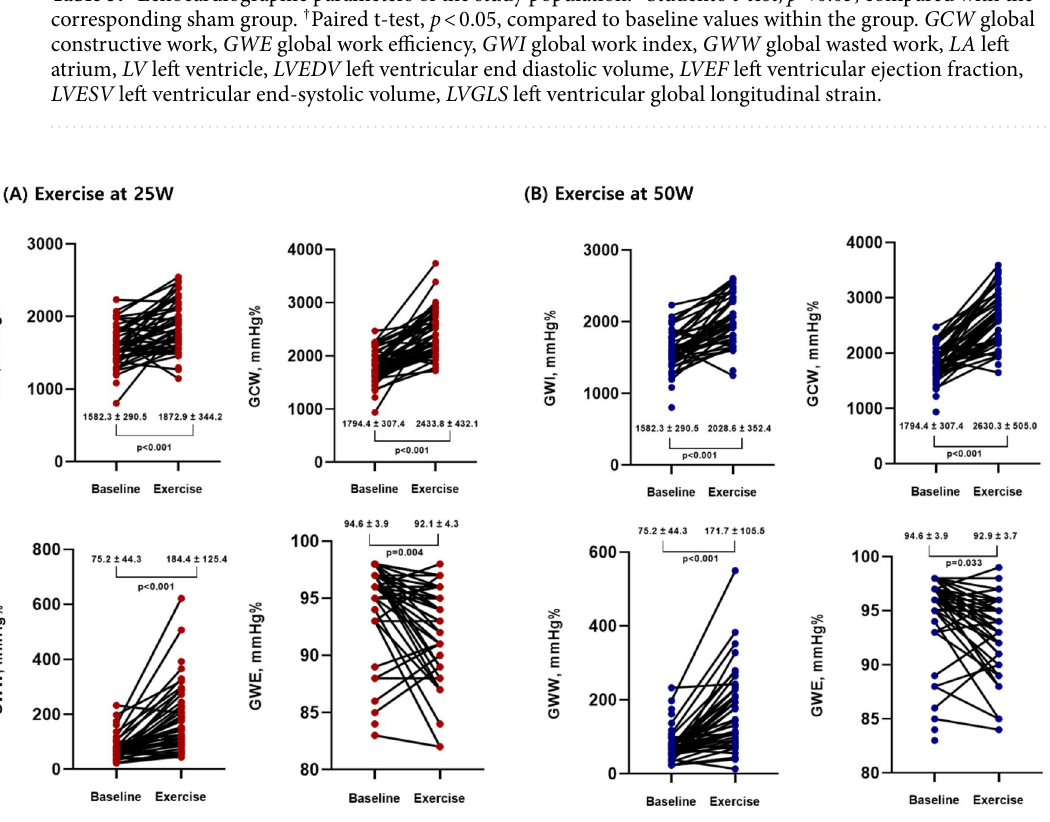
Figure 2. Comparison of myocardial work parameters between baseline and 25 W exercise ( A ) or 50 W exercise ( B ). CPAP, continuous positive airway pressure; GCW, global constructive work; GWE, global work efficiency; GWI, global work index; and GWW, global wasted